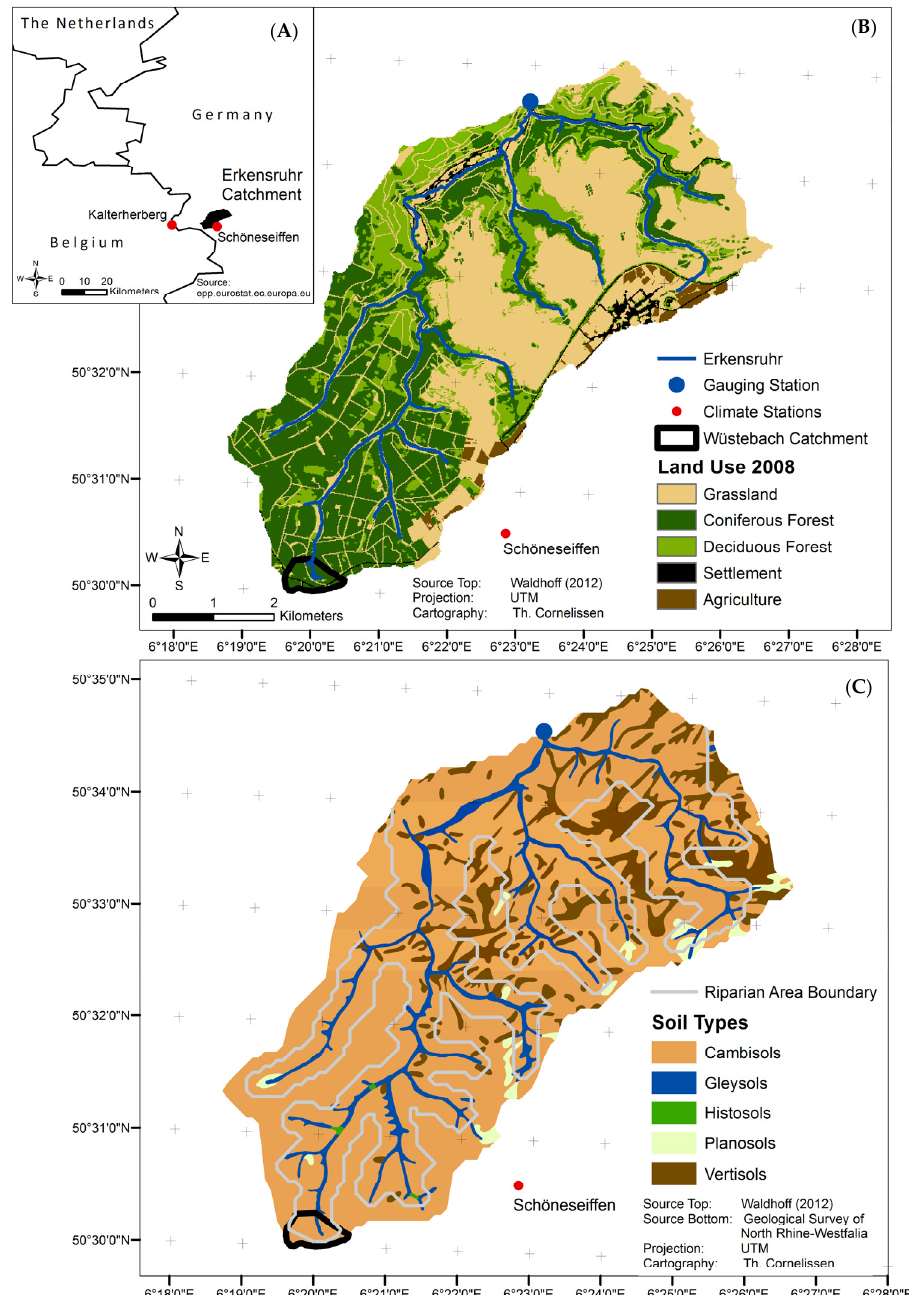
Figure 1. Location of the Erkensruhr catchment and climate stations ( A ); land use ( B ) and soil type distribution in the Erkensruhr catchment ( C ). The bottom map also illustrates the border between the slope of the hill and the riparian area (refer to Chapter 2.3).